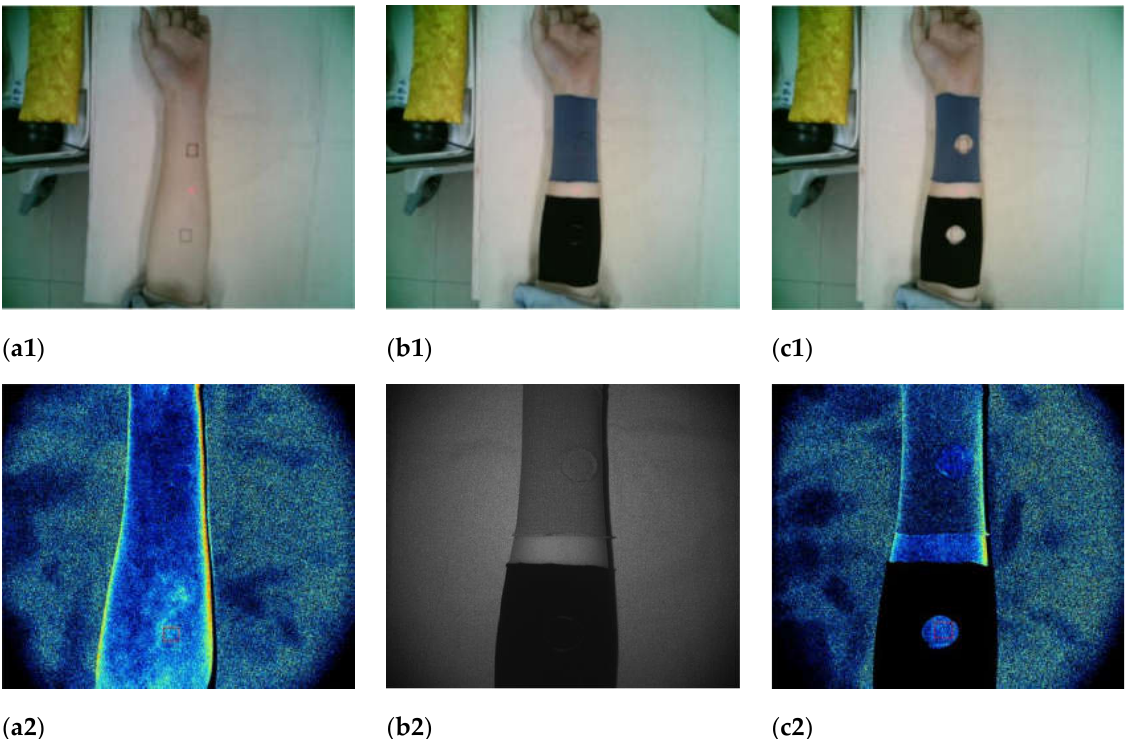
Figure 2. Extended forearm status and blood flow imaging of subjects’ non-dominant hand: ( a1 ) after the forearm of the non-dominant hand of the subject is placed on the experimental platform and kept in a relatively stationary state for 15 min, test points 1 and 2 were selected for blood perfusion measurement; ( b1 ) covered the sample for 20 min; ( c1 ) after the covering sample were removed, test point 1 and test point 2 were selected for blood perfusion measurement; ( a2 ) flow imaged when the sample was not covered; ( b2 ) covered sample process; ( c2 ) blood flow imaged after covering the sample.